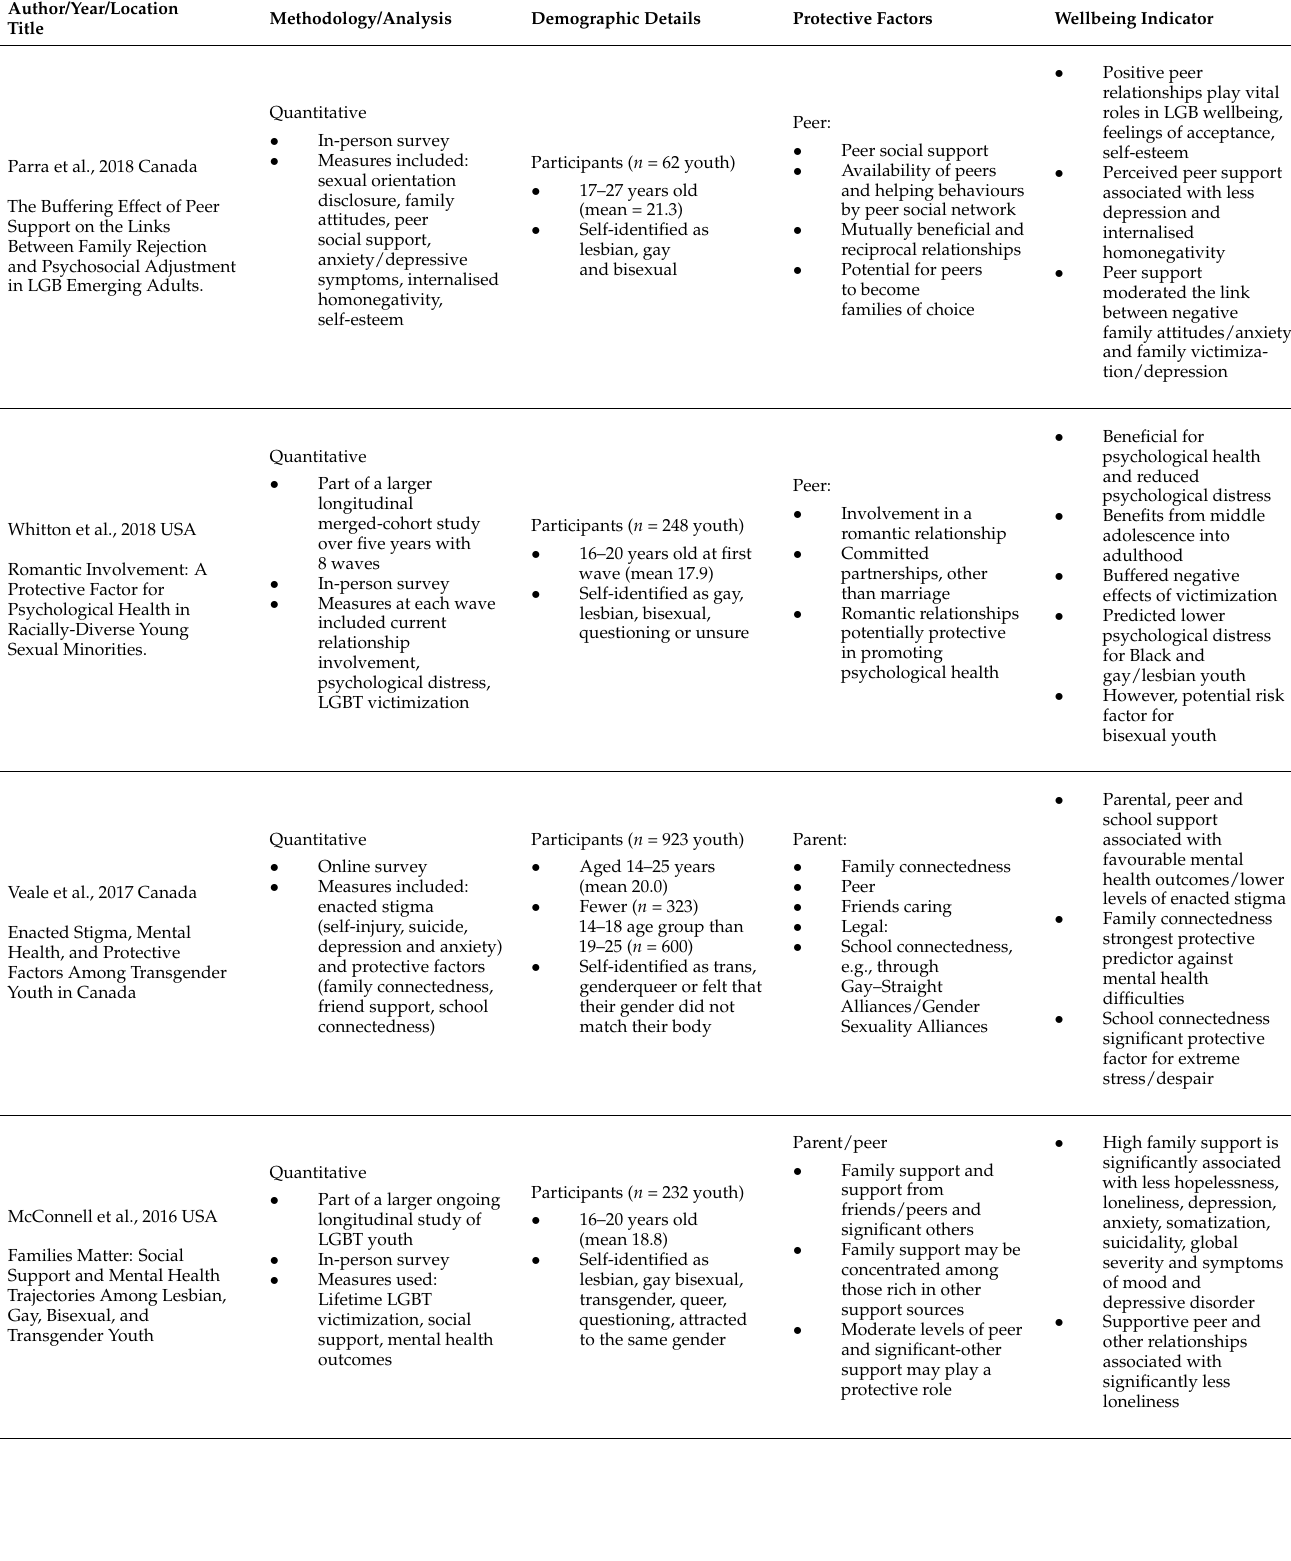
Table 2. Quantitative records of interpersonal relations: parental, peer and provider protective factors for LGBTI+ youth wellbeing ( n =